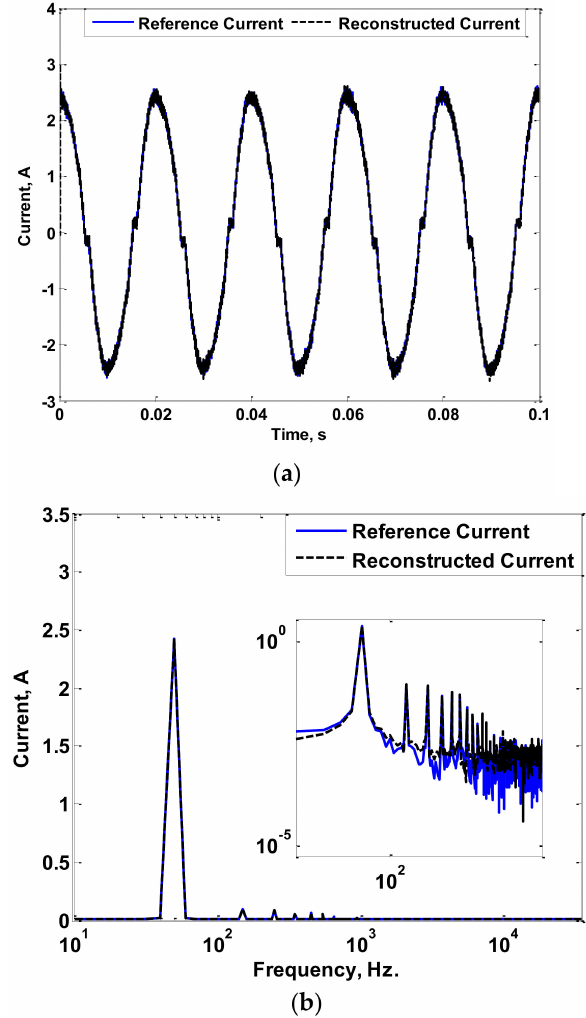
Figure 16. Reference and Reconstructed Currents of a 300 W luminaire Considering 35 kHz: ( a ) Refer- ence and Reconstructed Current Waveforms; ( b ) FFT of Reference and Reconstructed